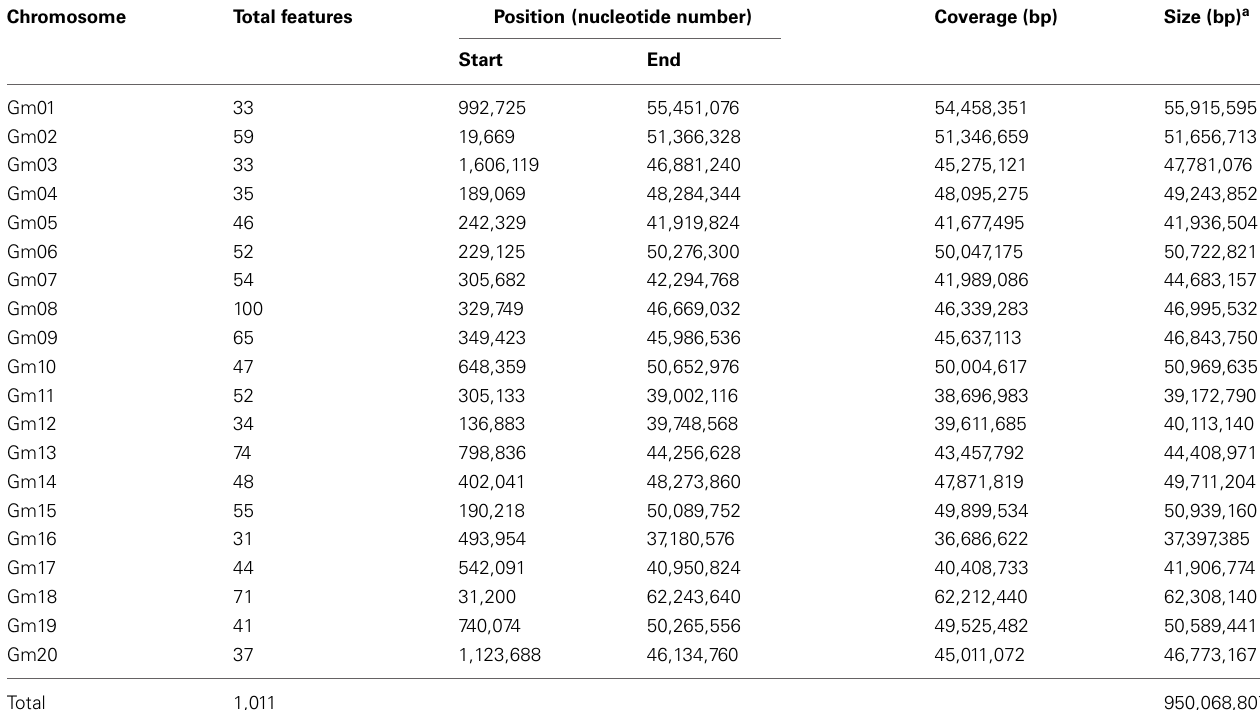
Table 5 | Characteristics of soybean phenylpropanoid pathway gene-based sequence map.